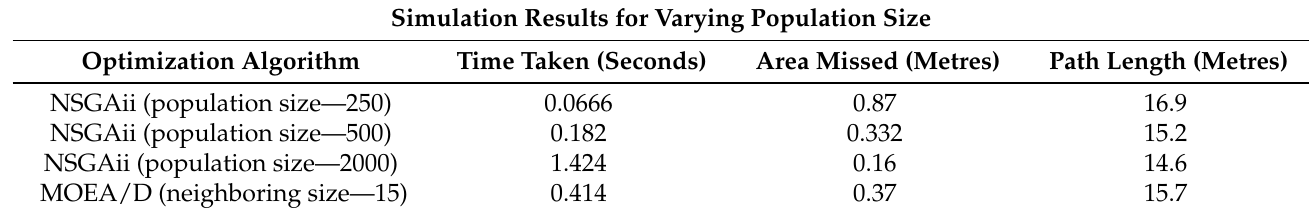
Table 1. Consolidated simulation results for varying population